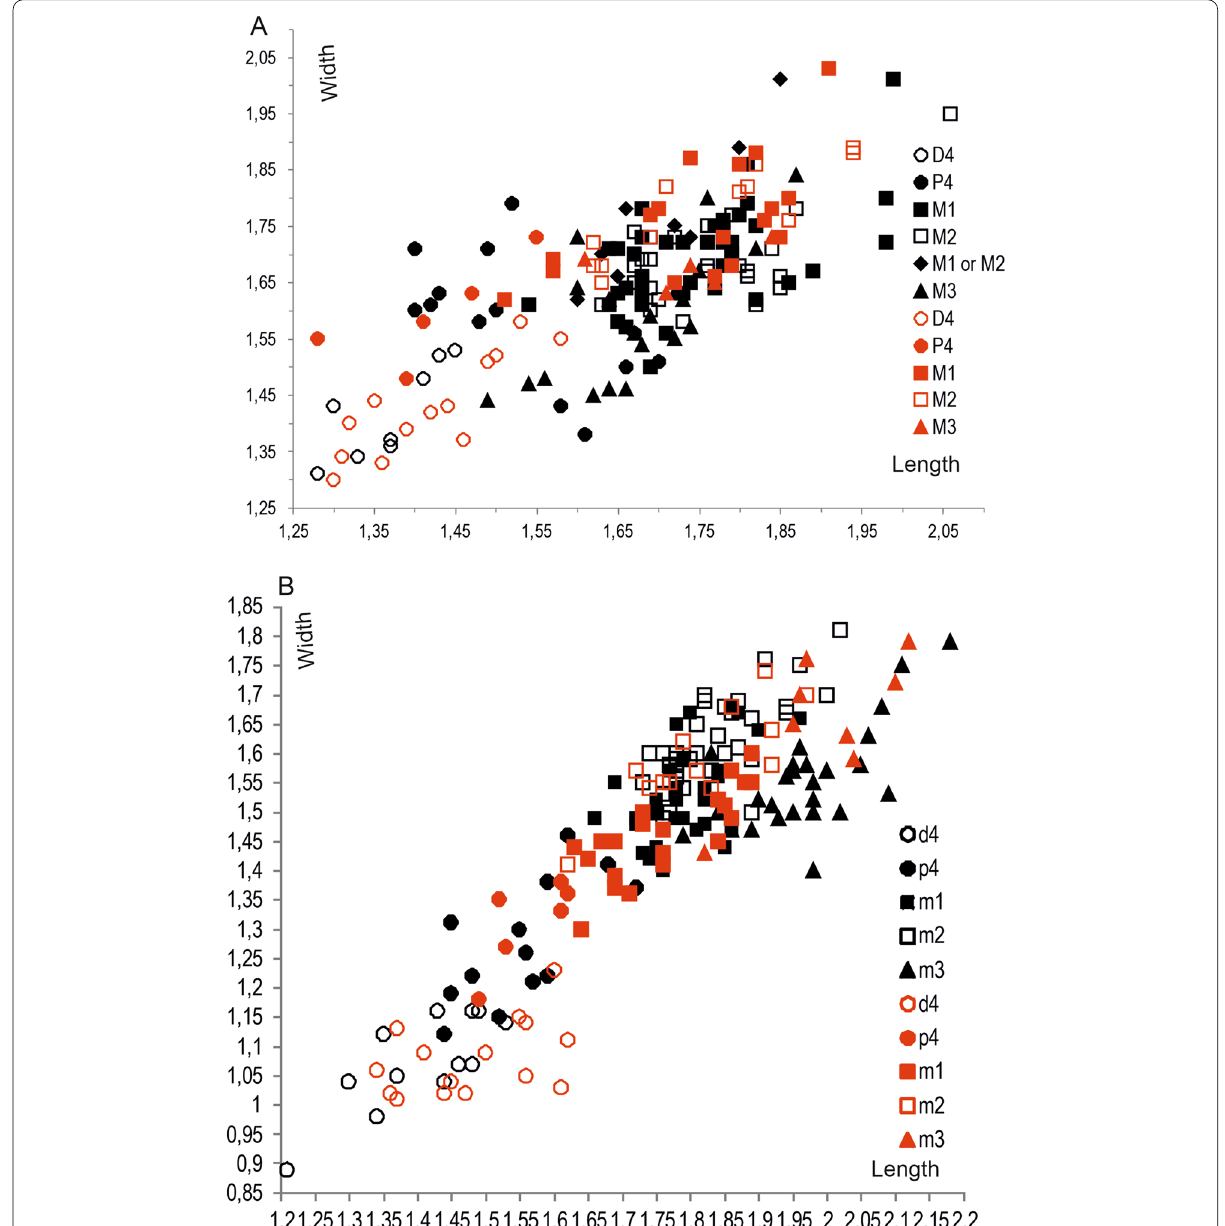
Fig. 44 Bivariate graph (width/length) of the size of the upper ( A ) and lower ( B ) teeth of ? Protadelomys maximini Escarguel, 1998 from Saint‑Maximin (Gard) (red marks), compared to the size of teeth of ? Protadelomys alsaticus Hartenberger, 1969 from Bouxwiller (Bas‑Rhin) (black